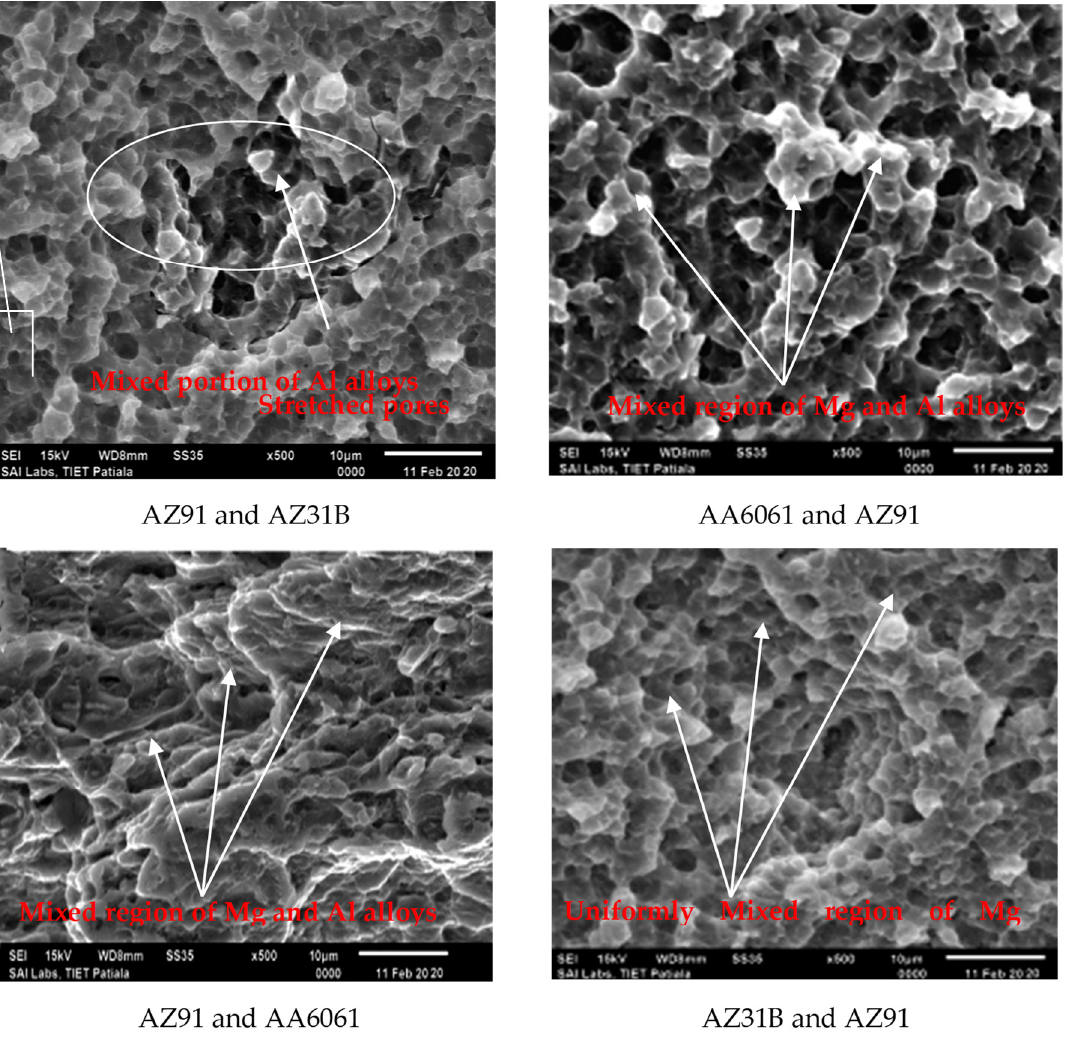
Figure 10. Fractography represents ductile fracture in CC, AA6061 and AZ91, AZ91 and AA6061, and AZ31B and AZ91 joints of FSW.